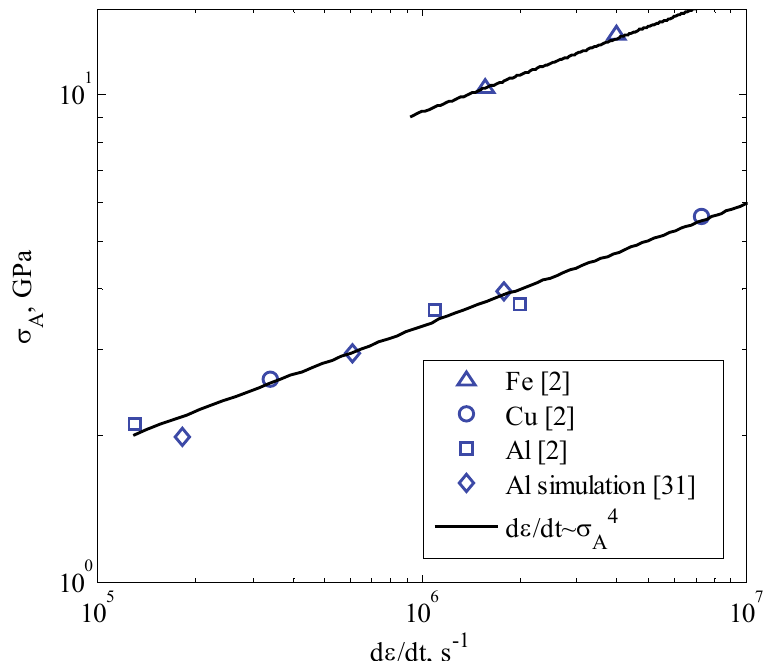
Figure 8: Dependences of the stress amplitude versus the strain rate at the shock front for metals